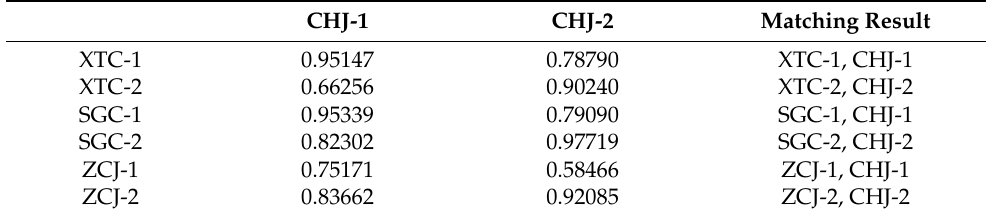
Table 4. Correlation coefficients and matching results between the encoding features of the CHJ station and the other three stations.